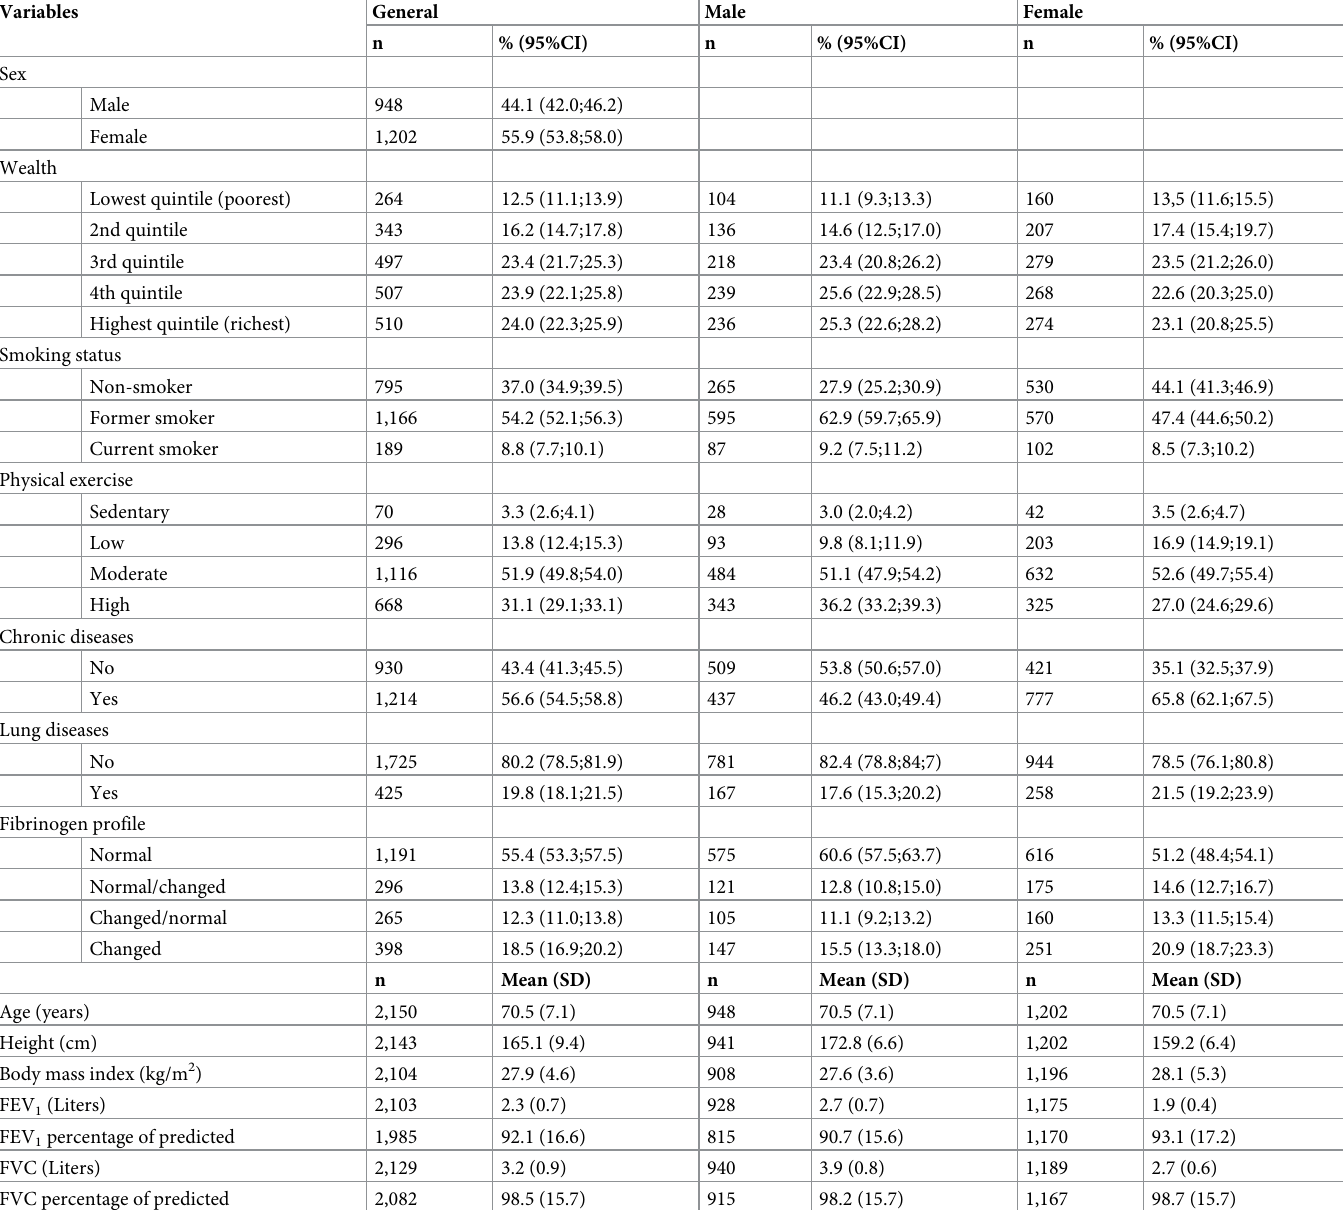
Table 1. Descriptive analyses of participants from ELSA who presented complete data for fibrinogen in wave 2 (2004–05) and 4 (2008–09) and lung function in wave 6 (2012–13), The English Longitudinal Study of Ageing, England, 2004 to 2013.